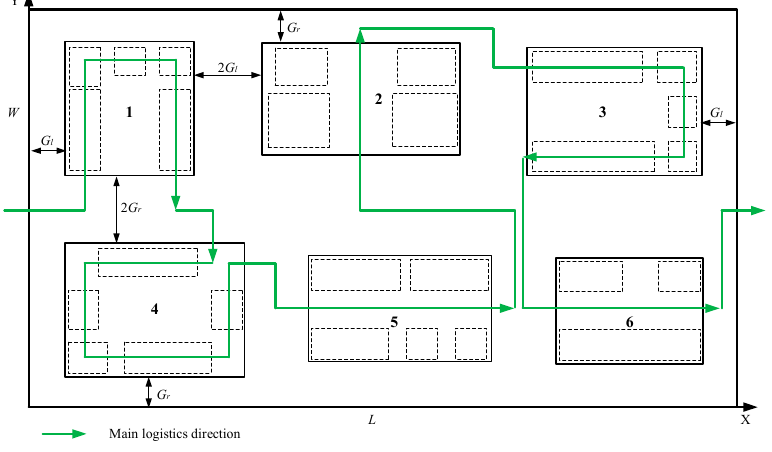
Figure 3. Plane diagram of MCIL.